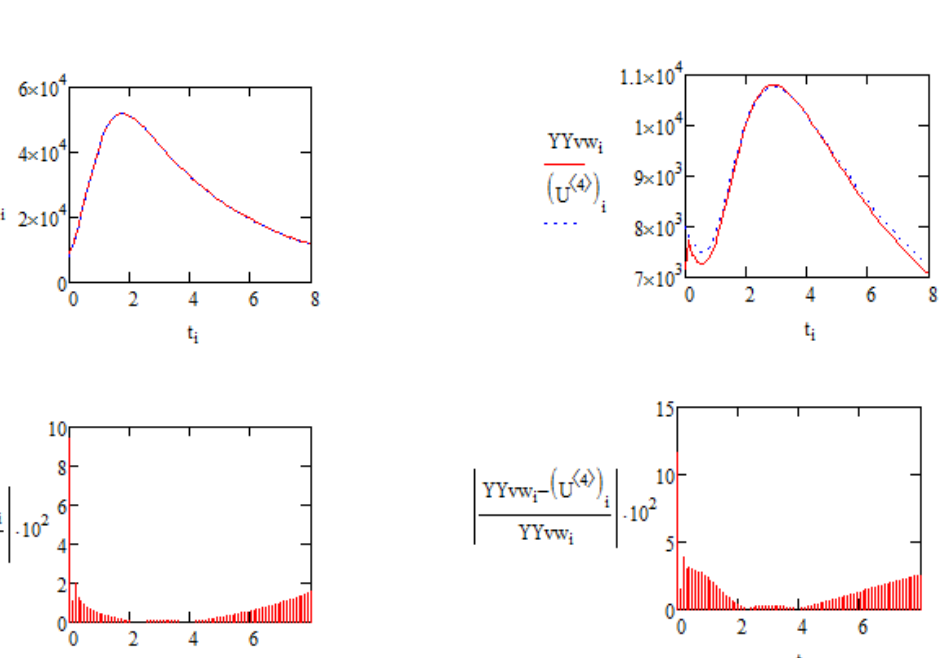
, and the percentage relative i